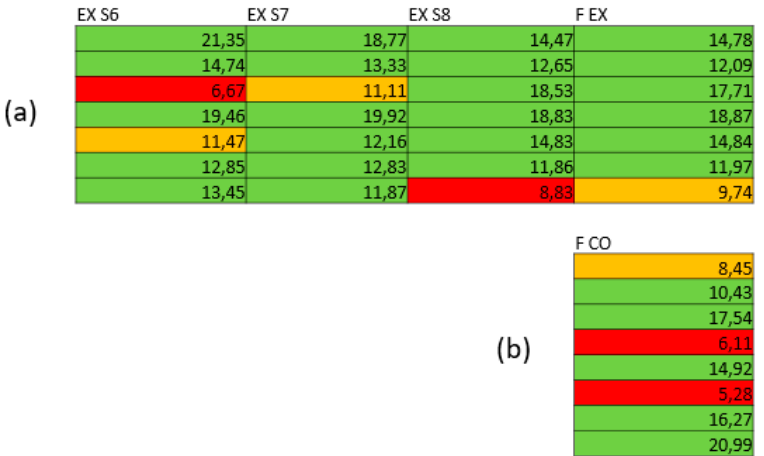
Figure 6. Traffic light depicting alert levels of the teams shown in the last three synchronous sessions and the final evaluation ( a ) Experimental Groups and ( b ) Control groups (only final evaluation).